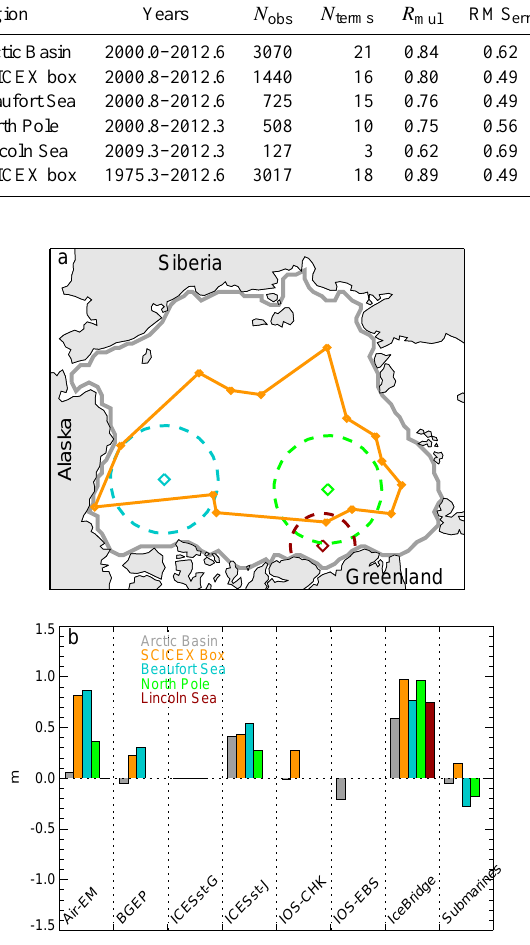
Figure 7. (a) Locations of five regional fits for the period 2000– 2012 and (b) relative magnitudes of the ITRP indicator coeffi- cients. The magnitudes of the coefficients are grouped by obser- vation source and color-coded by region (the order of the bars is the same as that of the region names). Grey depicts the coefficients for the fit for the entire